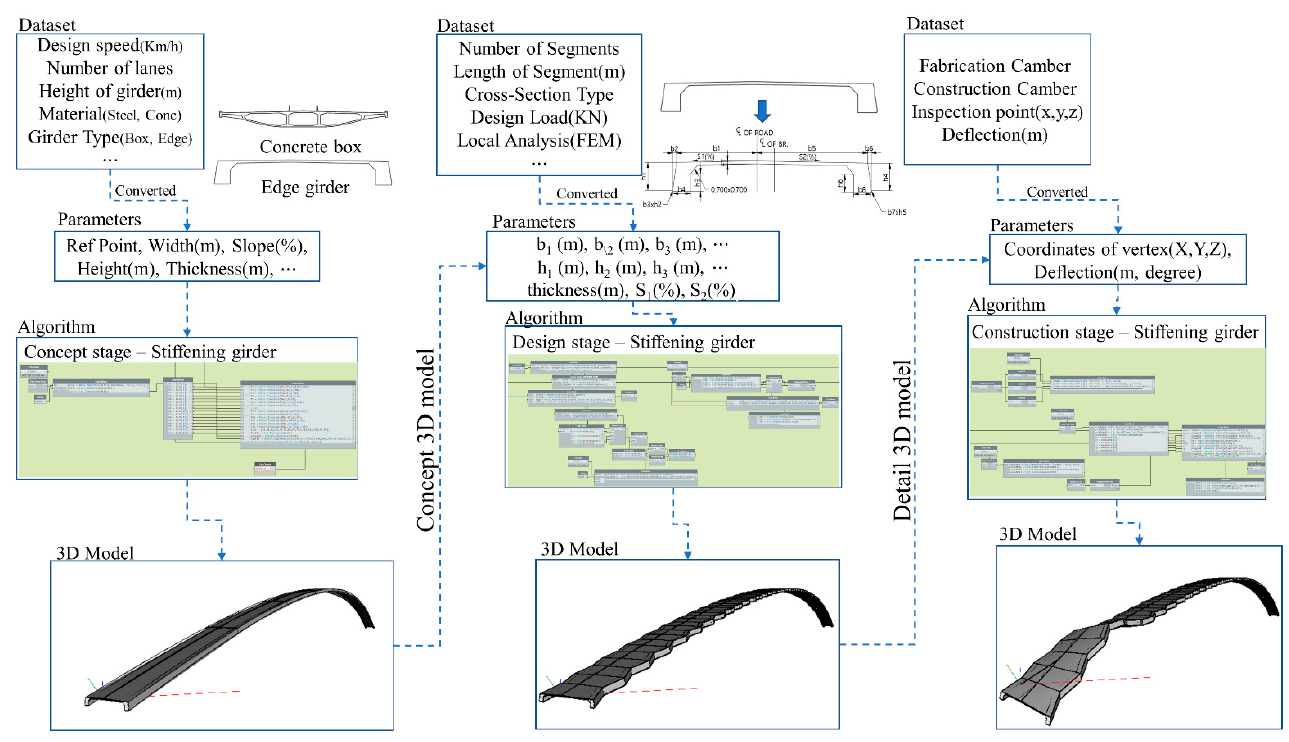
Figure 5. Modeling algorithms and datasets for different phases.